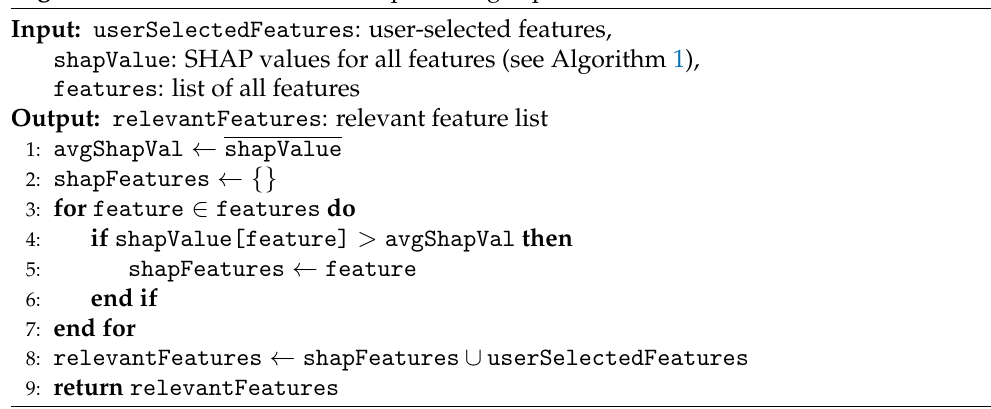
Algorithm 2. Feature selection for providing